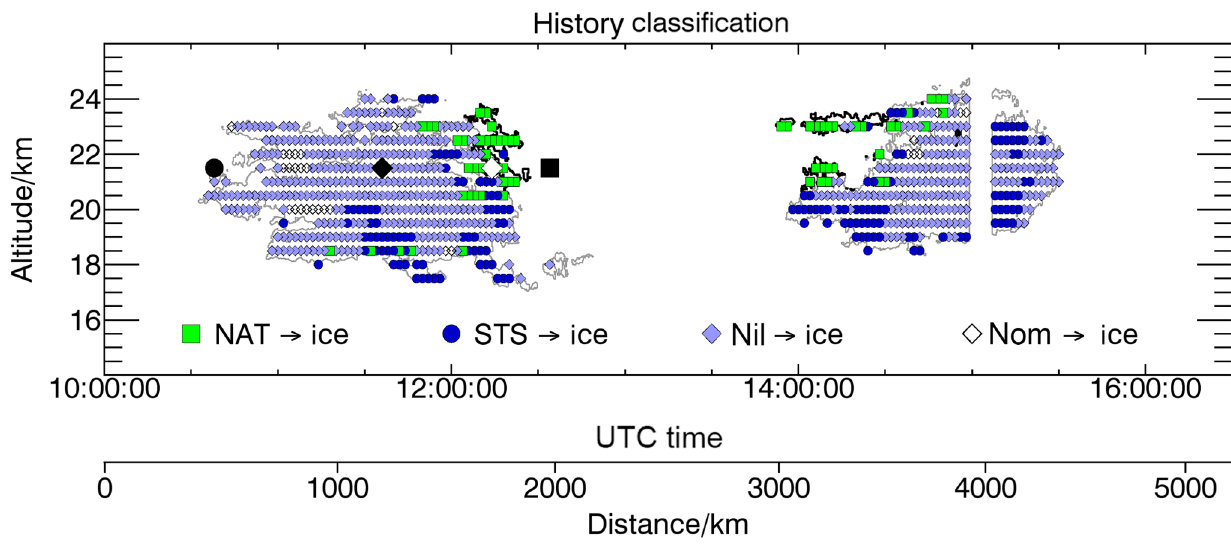
Figure 9. PSC type measured by CALIPSO prior to ice on match points with 5-day back-trajectories. Green squares indicate that NAT has been measured by CALIPSO prior to ice, blue circles indicate STS prior to ice, and light blue diamonds (nil) indicate that no PSC has been observed and (nom) that no match point of the trajectories and the CALIPSO curtain exist within 5 days. NAT has been detected by CALIPSO prior to the high-depol ice mode measured by WALES (thick black contour line) and predominantly STS or no PSC have been detected prior to the low-depol ice mode measured by WALES (thin grey contour line). UTC times of the WALES ice PSC observations and the horizontal distance are given. The starting points of the four trajectories from Fig. 8 are indicated by the black and white